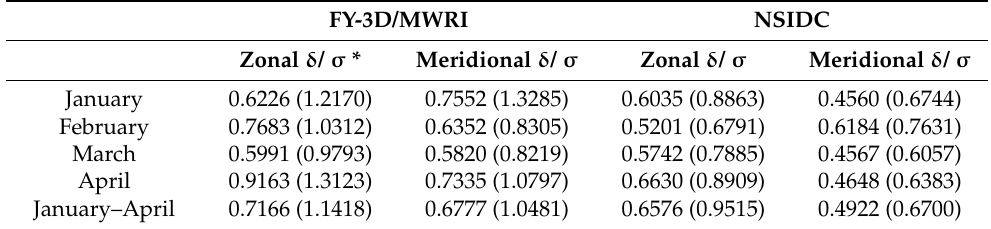
Table 6. Error-related statistics of the retrieved sea ice motion from FY-3D/MWRI T b and